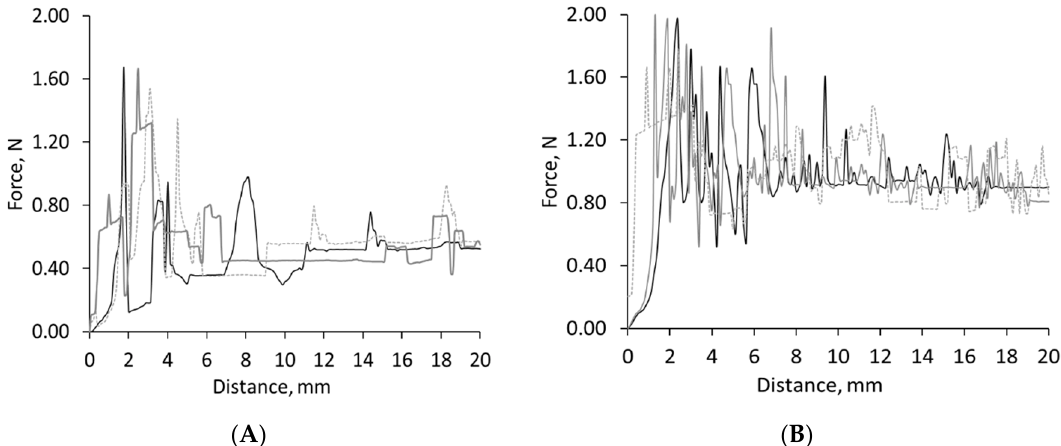
Figure 3. In vitro shear adhesion profile plotted as a function of distance for uncoated tablets. The oral gliding performance of tablets can be determined using a modified Hounsfield tensometer friction sledge across two non-anatomical oral mucosa-mimicking surfaces wetted with artificial saliva (polytetrafluoroethylene as graph ( A ) and sodium polyacrylate as graph ( B )). Uncoated tablets displayed an erratic creep profile caused by a stick–slip motion resulting in friction re-strengthening and the fragmentation of the tablet, as depicted by the frequent large stress drops of the shearing peaks in both oral mucosa-mimicking